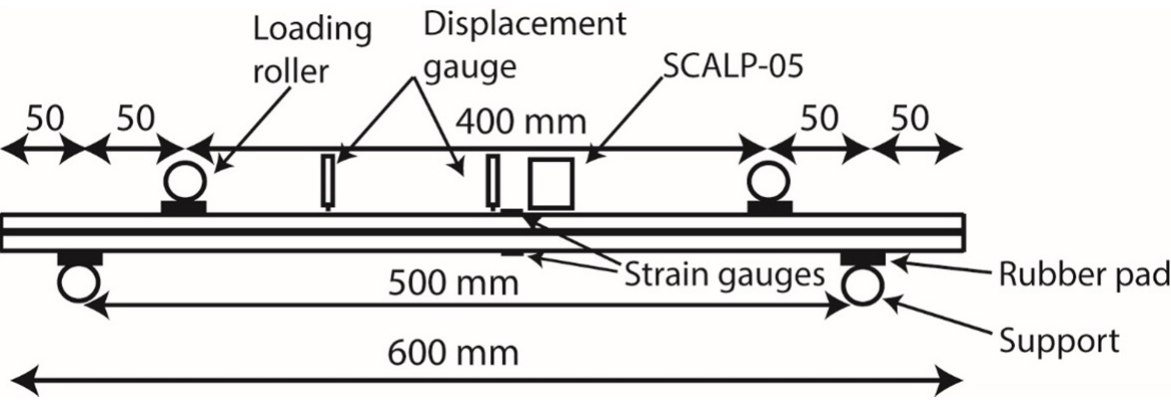
Fig. 2 Test setup configuration (All dimensions are in